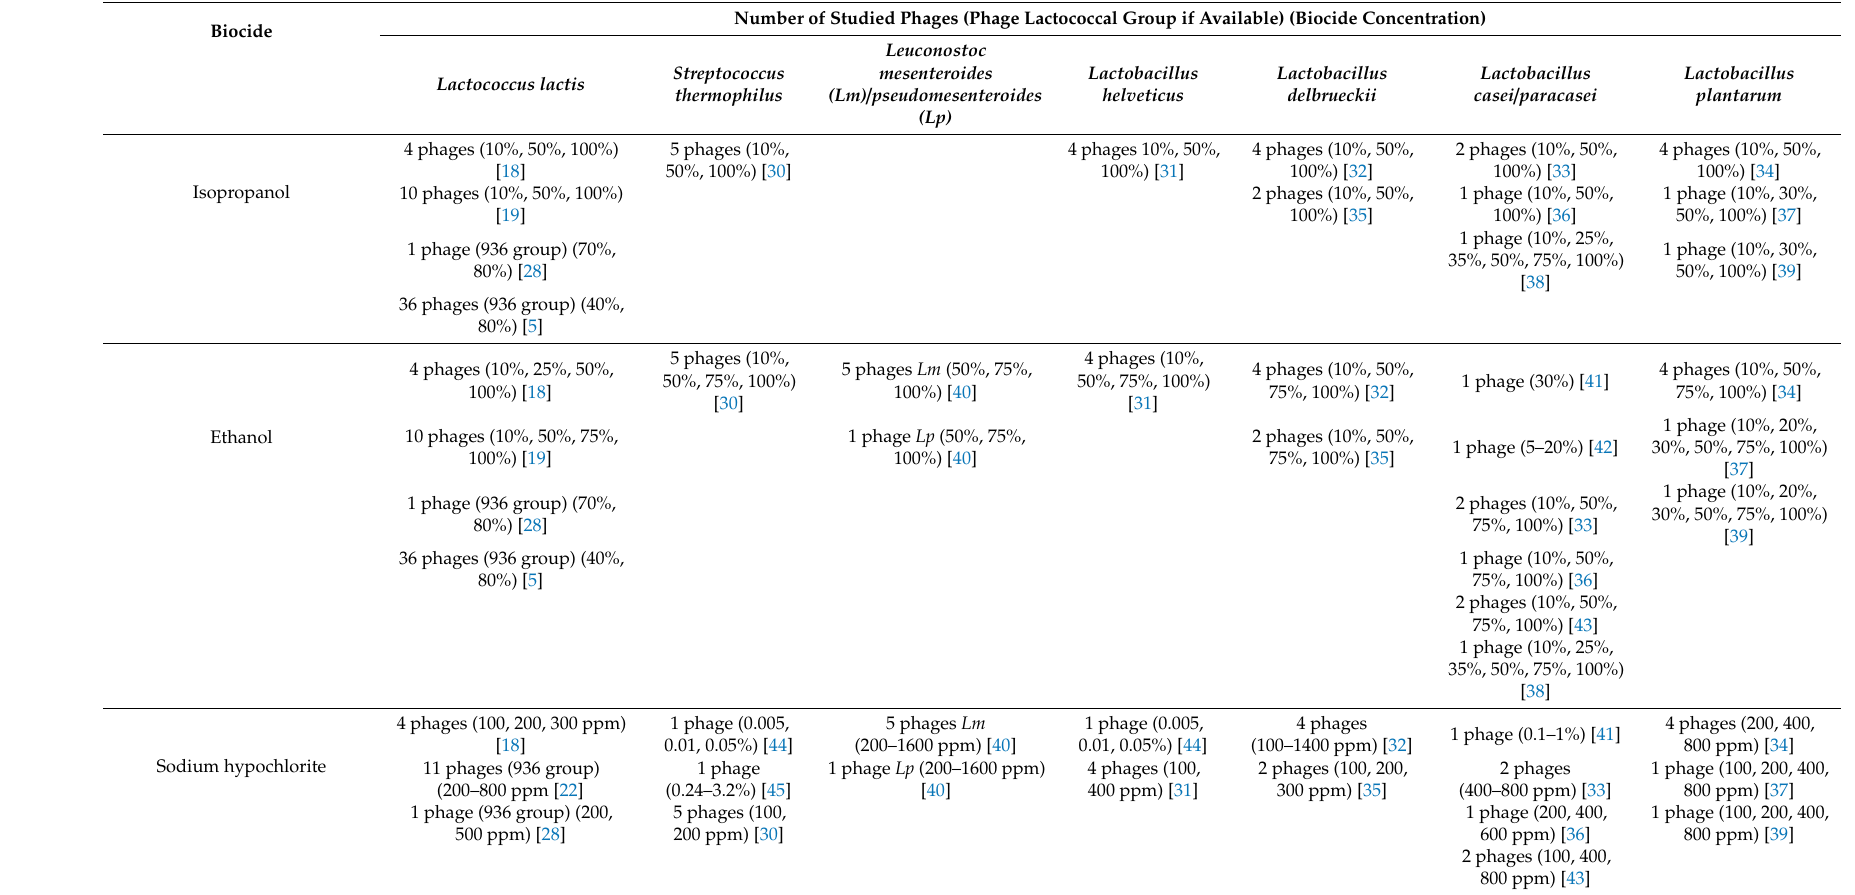
Table 2. Biocides studied for inactivation of dairy